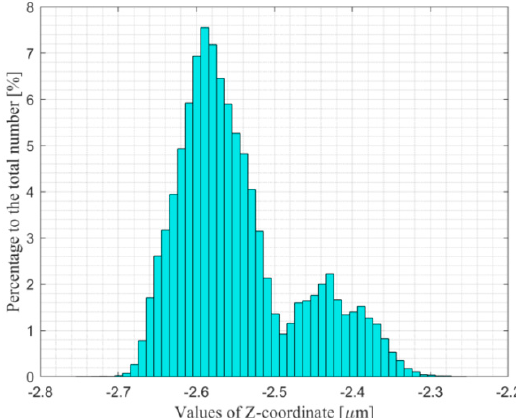
Figure 6. Histogram of the Z values of the rotated surface.